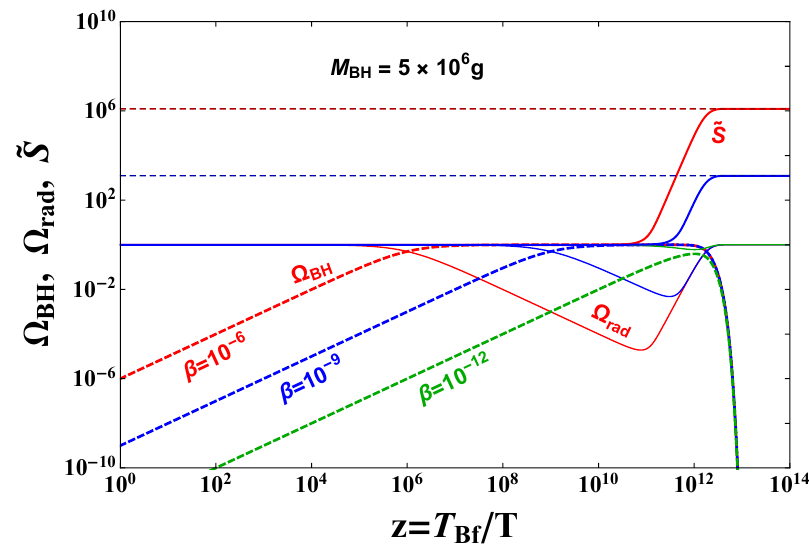
Figure 2 . Normalised energy densities as a function of inverse temperature (normalised to T Bf